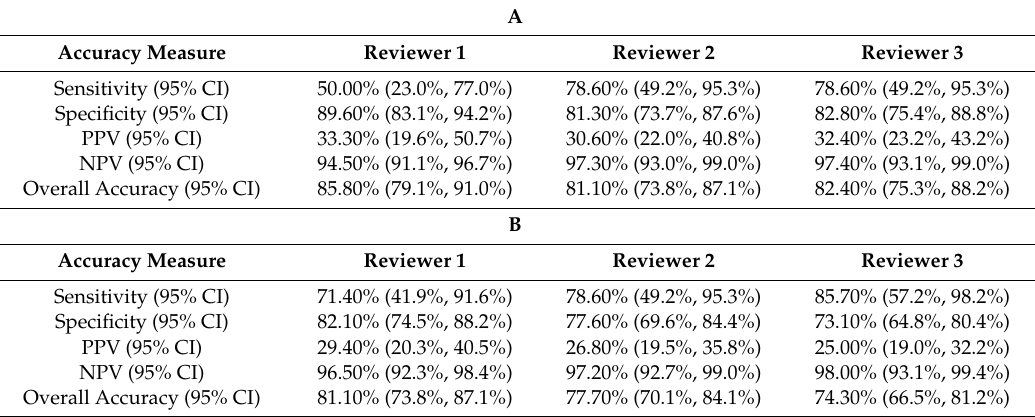
( A ) Reviewer accuracy in patient diagnosis. ( B ) Reviewer accuracy in